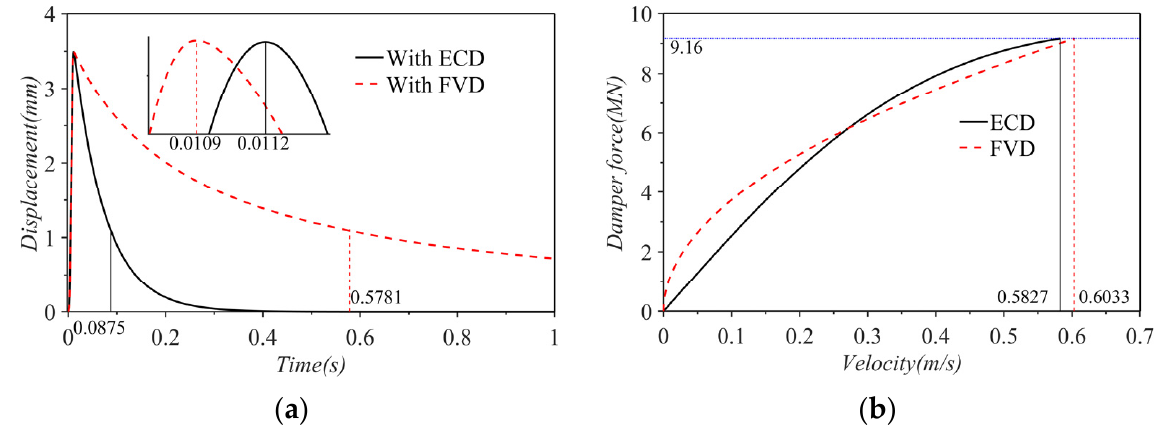
Figure 8. Responses of the SDOF systems with an ECD or FVD subjected to half-cycle sine shock at the same maximum displacement and damper force: ( a ) Displacement time history; and ( b ) Force-velocity relationships of the ECD and the FVD within the time history.